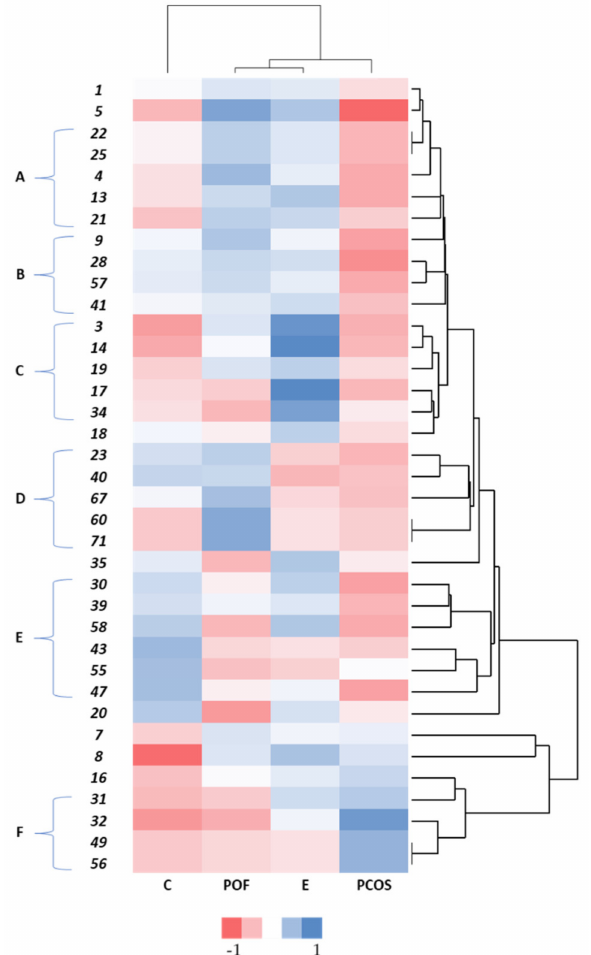
Figure 2. Heatmap of the correlation and tendencies between the FFs of the four medical conditions and respective VOCs. The abscises correspond to: (C) controls; (POF) premature ovarian failure; (E) endometriosis; (PCOS) polycystic ovary syndrome. The coordinates represent the VOCs con- sidered, which were assigned numbers. They were separated into six groups according to their distribution throughout the samples. Each number corresponded to a single VOC: (1) palmitic acid; (3) tetradecanal; (4) 2,4-di-tert-butylphenol; (5) diethyl phthalate; (7) 1,2,3,4-tetramethylbenzene; (8) 4- methyl-2,4-bis(4-hydroxyphenyl)pent-1-ene; (9) palmitic acid ME; (13) isopropyl myristate; (14) oc- tadecanal; (16) tetradecamethylcycloheptasiloxane; (17) hexadecanal; (18)